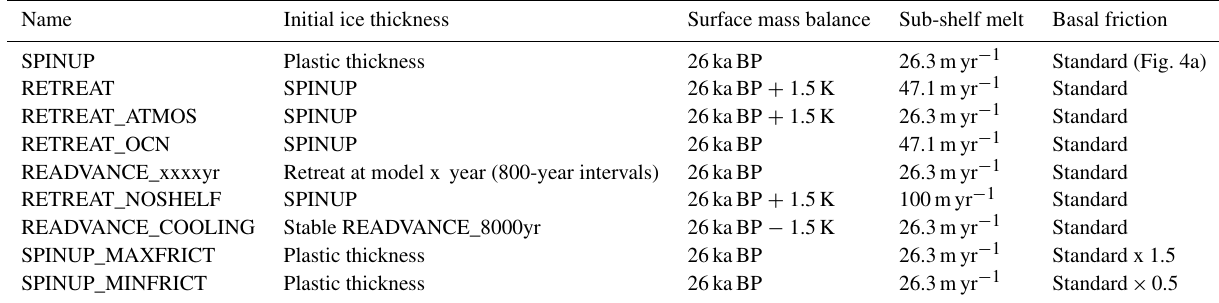
Table 2. Summary of experiment set-up and forcing. Plastic ice thickness is shown in Fig. 2a, the SPINUP thickness in Fig. 3b, and the difference between the plastic thickness and SPINUP thickness in Fig. 3c. Surface mass balance at 26kaBP is shown in Fig.